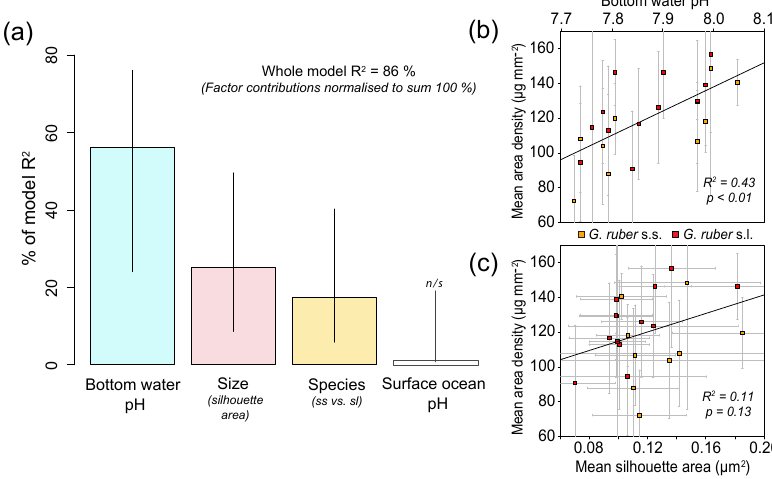
Figure 4. Drivers of ρ A in core-top G. ruber (white). In (a) , the relative importance of environmental (surface and deep ocean pH) and physiological (size and species) factors in predicting ρ A are shown. A multiple linear regression model containing bottom water pH (i.e. pH at the site of deposition), test size (i.e. mean silhouette area in the core-top sample), and morphospecies (i.e. G. ruber (white) sensu stricto vs. sensu lato) can describe 86% of the variance in ρ A , with all predictors significant to p < 0 . 01 except surface ocean pH, which is not a significant contributor to the model but is shown here for illustrative purposes only (see also Table S3). Of these variables, bottom water pH is the strongest correlate, as determined by the R package relaimpo (Groemping, 2006). Uncertainty bounds on the relative contribution of each variable are determined via bootstrapping. Univariate regression lines of ρ A vs. bottom-water pH and vs. mean test size are shown in (b, c) respectively. Error bars on ρ A are 2SD of variation within core-tops (b, c) . Error bars on mean silhouette area (c) are 2 standard deviations of silhouette area within a core-top sieve size fraction. In each case, G. ruber sensu stricto are plotted in orange, and sensu lato in red. Generally heavier values of ρ A are observed in G. ruber sensu lato (b, c) , constituting the third most important control on ρ A within our core-top dataset (a) . Multiple linear regression statistics are given in Table S3. Residual variation in ρ A around the relationship with bottom water pH is significantly correlated with test silhouette area ( R 2 = 0 . 35, p < 0 . 01; see Fig. S5). Note that other deep-ocean carbonate system parameters ( (cid:127) , (cid:49) [CO 2 − ]) were also trialled in multiple regression models, but the strongest correlation was observed with pH at 3 each core-top site, and so that variable is preferred